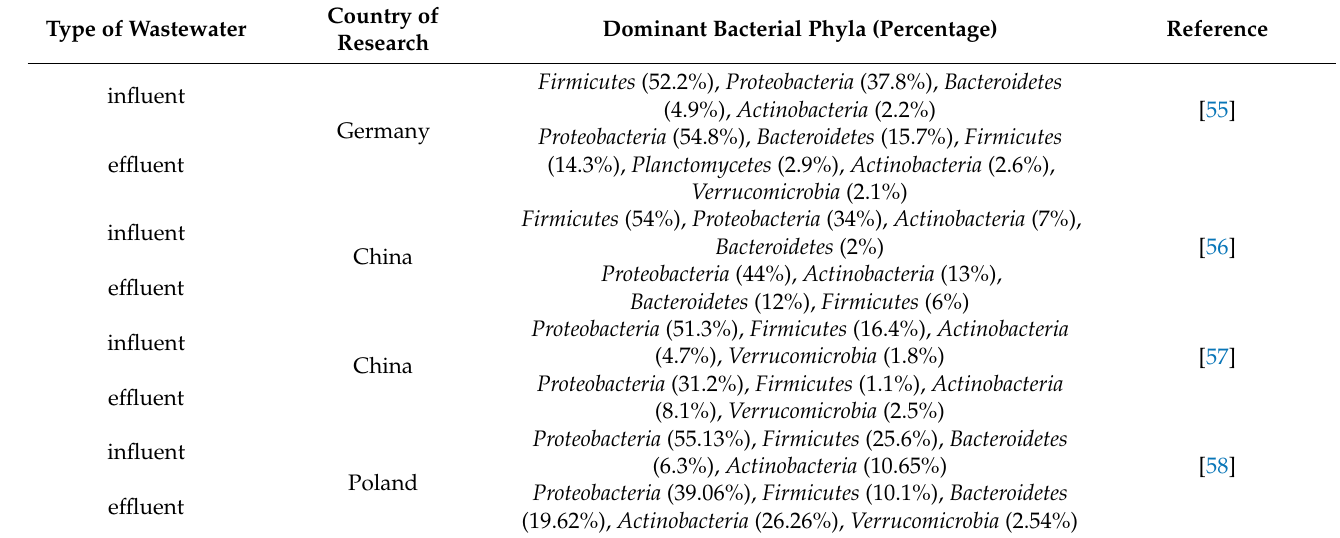
Table 1. The dominant bacterial phyla in WWTPs influent and